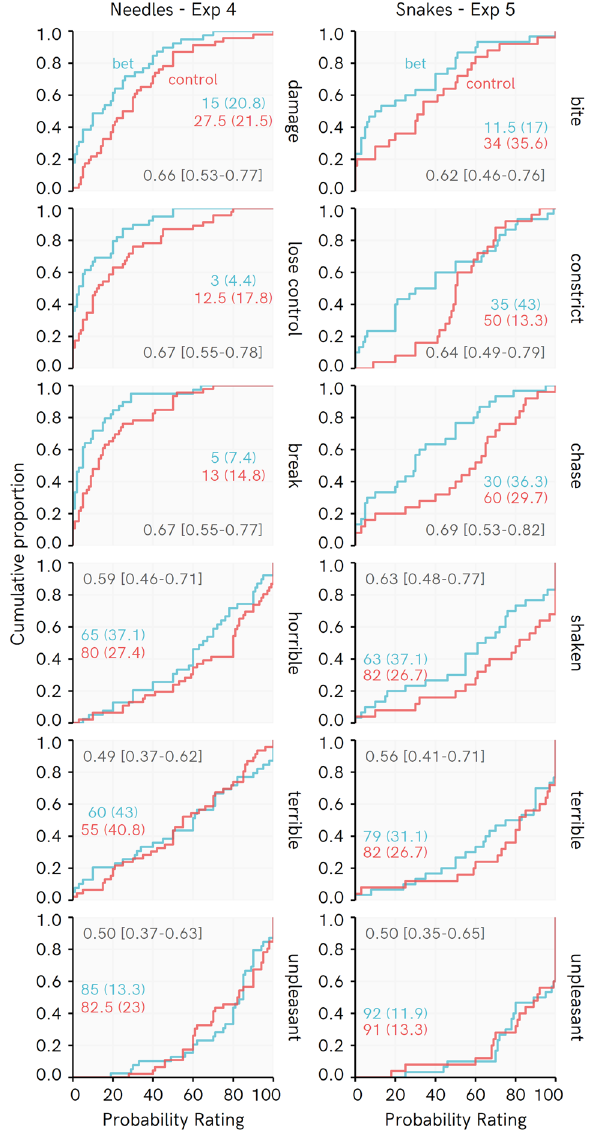
Figure 5. Cumulative distributions for beliefs in Experiments 4 and 5, with raw probability of superiority values and bootstrapped 95% bias corrected accelerated confidence intervals. Colored numbers reflect Median and (Median absolute